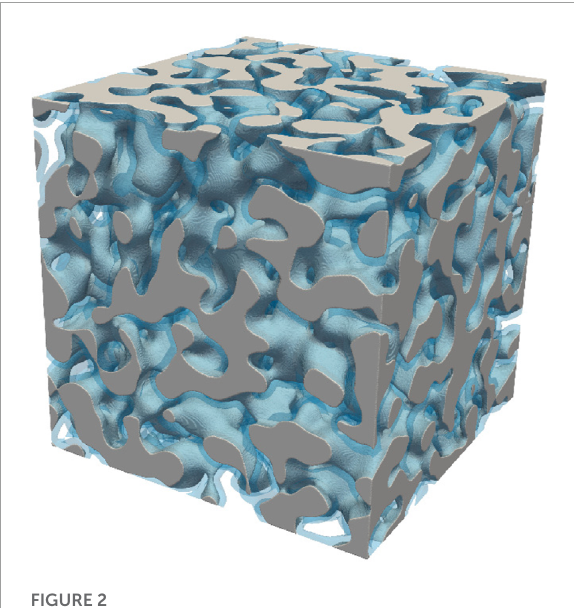
FIGURE 2 Illustration of a three-phase model with a = 4 nm, ϵ = 0 . 60, and ν = 0 . 50. For an illustration of a single 2D slice from this model, see Figure 1